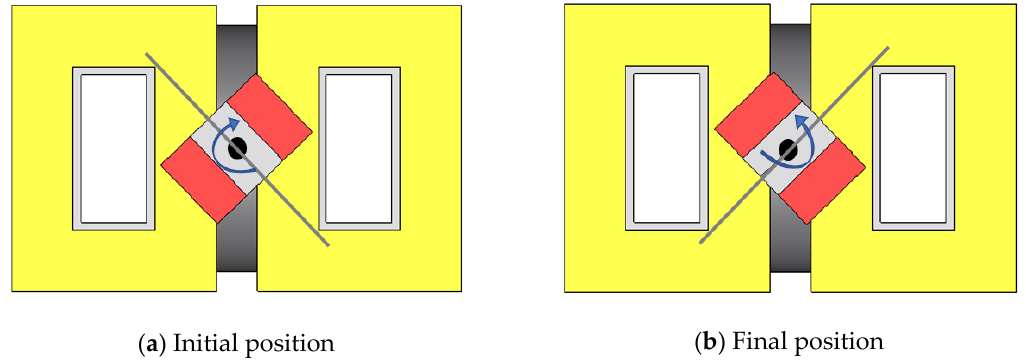
Figure 4. Upper view of the electromechanical LAT actuator ( a ) initial and ( b ) final rotor positions. Figure 4. ( a ) Initial and ( b ) final positions of the electromechanical LAT actuator.